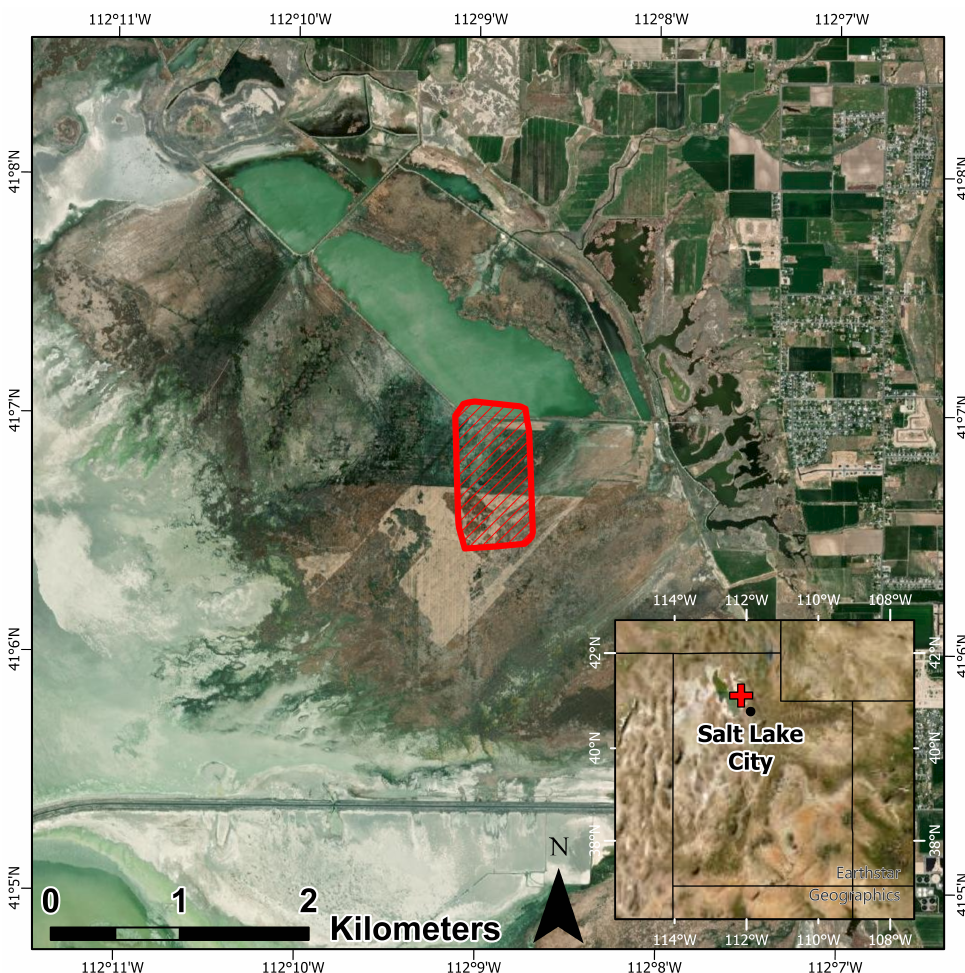
Figure 1. Satellite imagery of the flight area (red crosshatch) in the Howard Slough Waterfowl Management